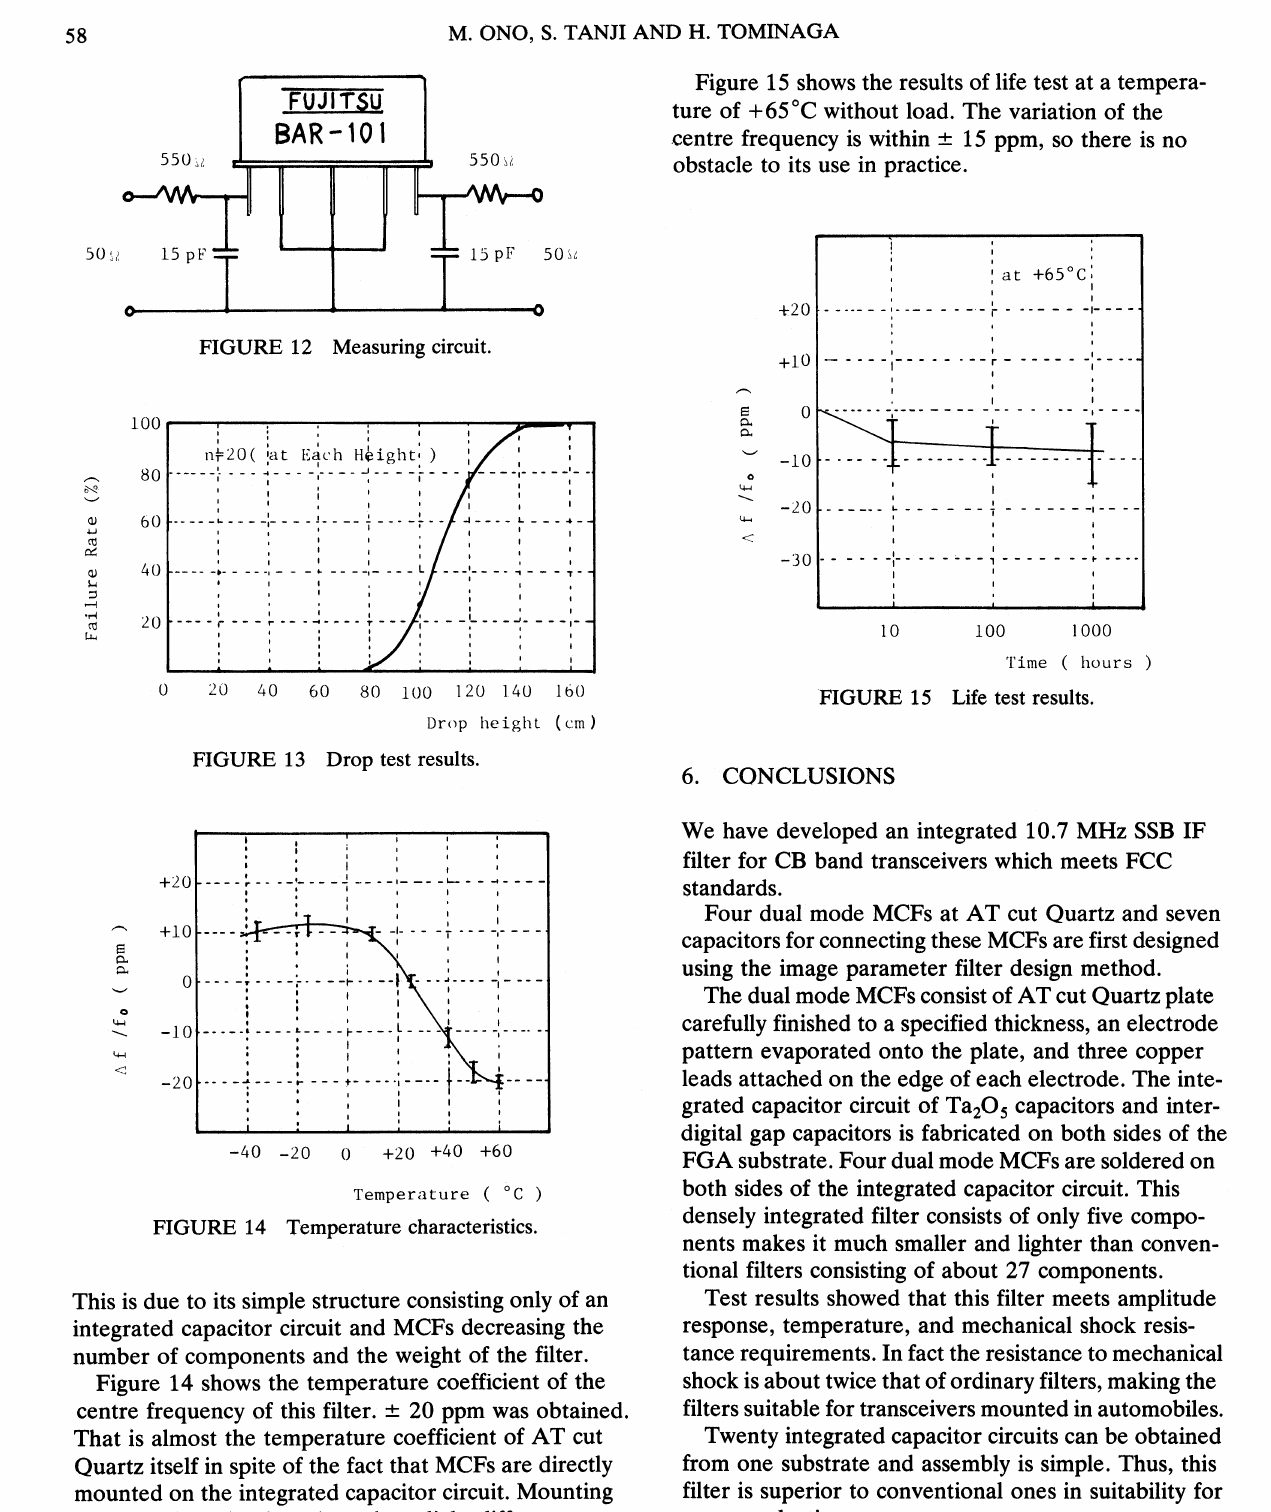
FIGURE 12 Measuring circuit.